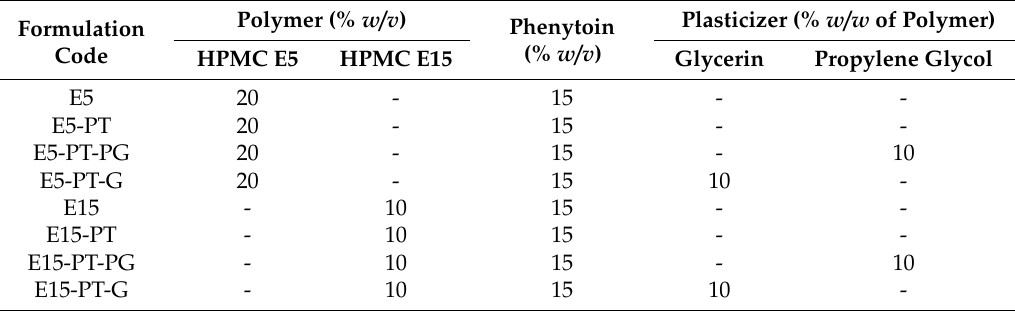
Table 1. Composition of di ff erent formulations of 3D-printed